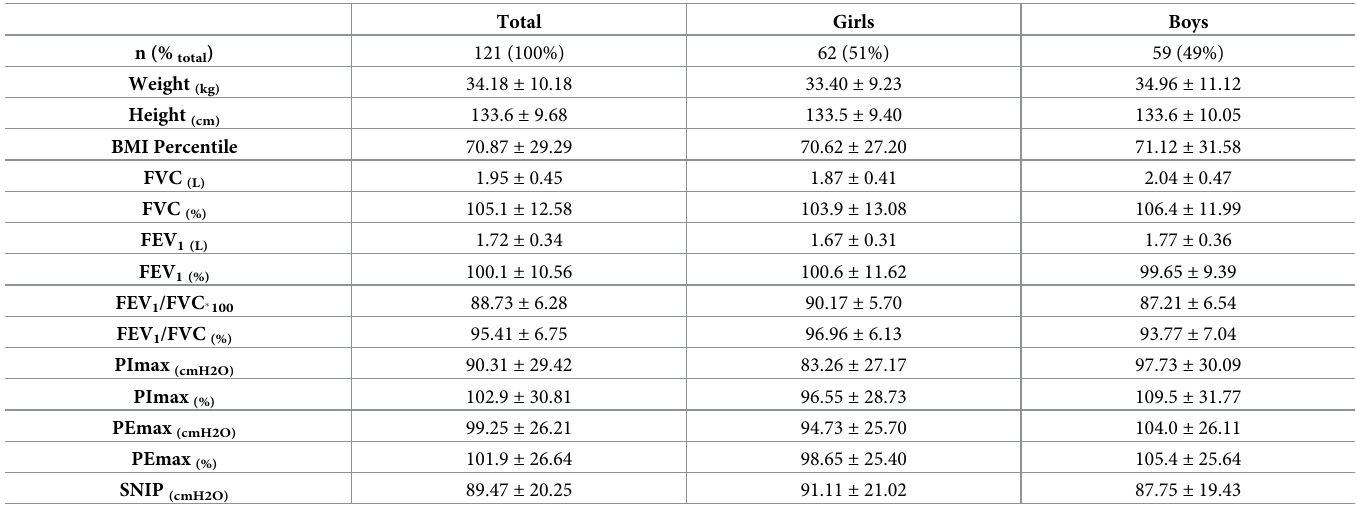
Table 1. Anthropometric data and pulmonary function stratified by